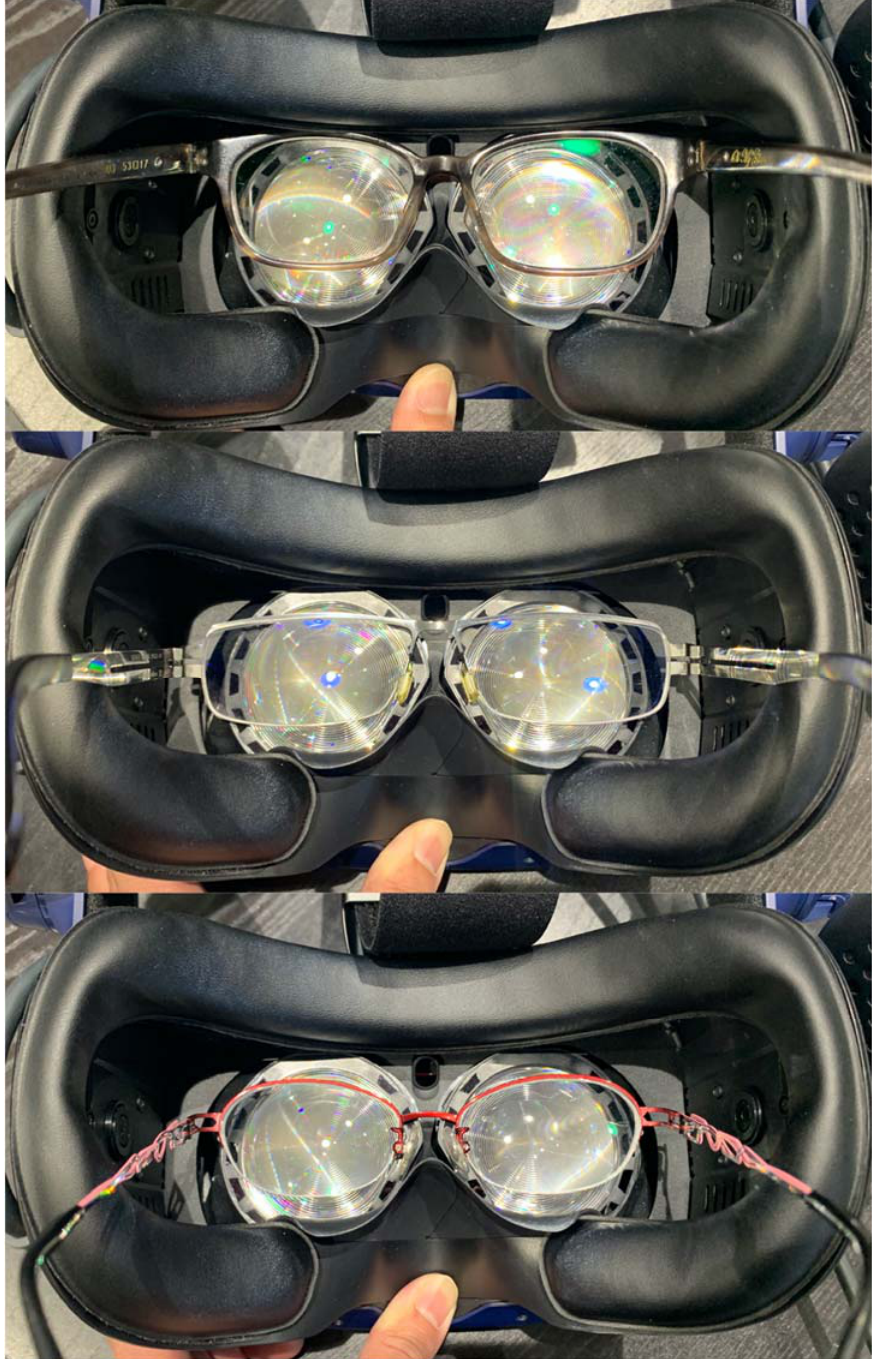
Figure 6. Simulation of the upward displacement of eyeglasses in different frames from an outside view.